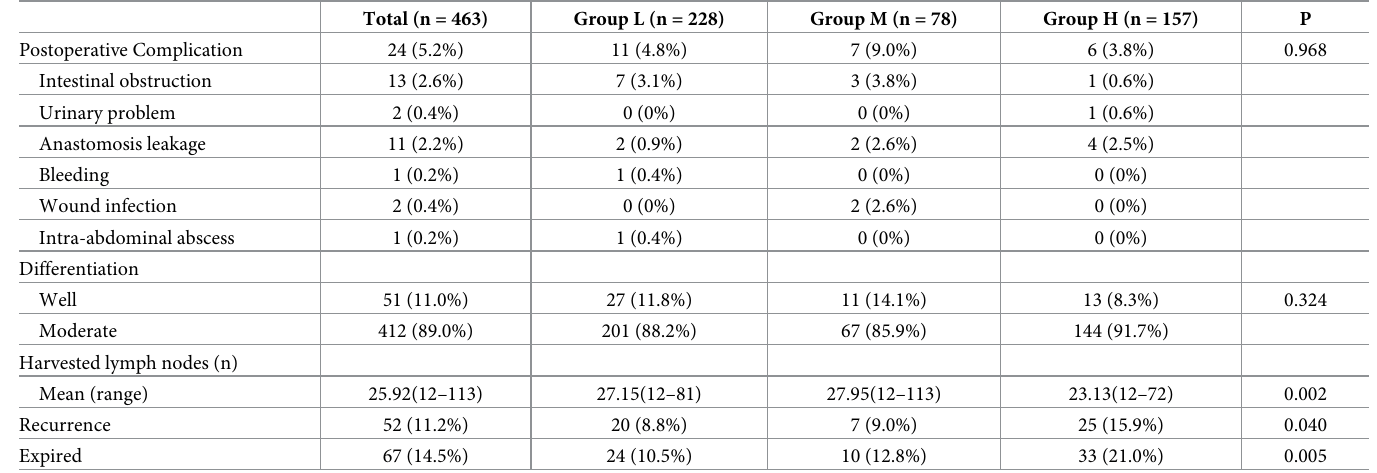
Table 4. Postoperative